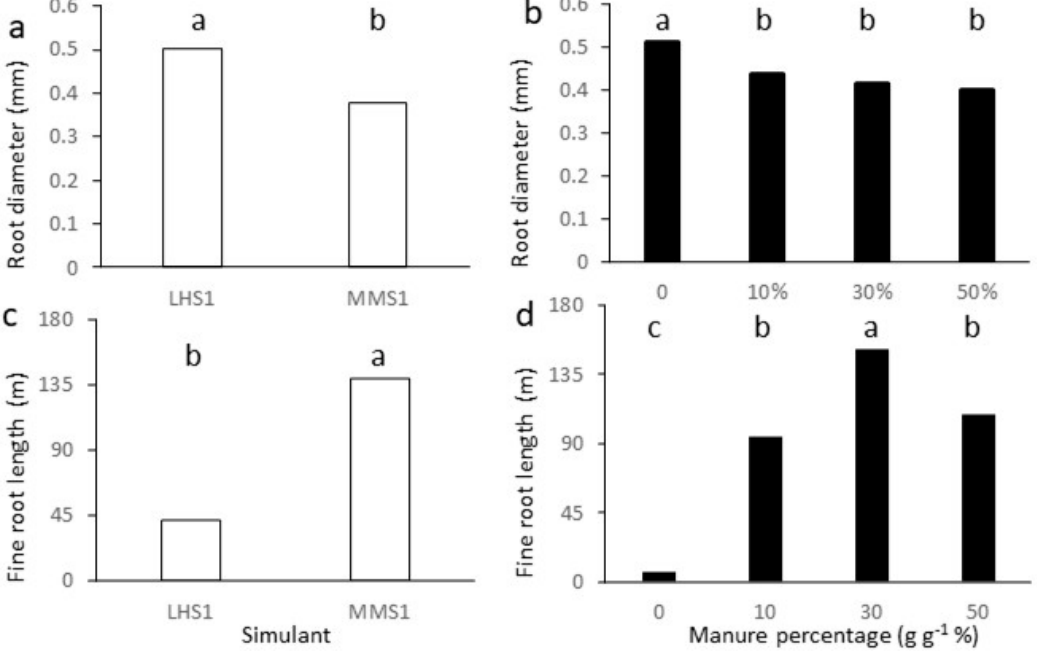
Figure 1. Main effects of simulant ( a , c ) and manure concentration ( b , d ) on root diameter ( a , b ) and length of roots with diameter < 0.5 mm ( c , d ). Bars with different letters are different for p < 0.05 at the post hoc Duncan’s mean separation test.